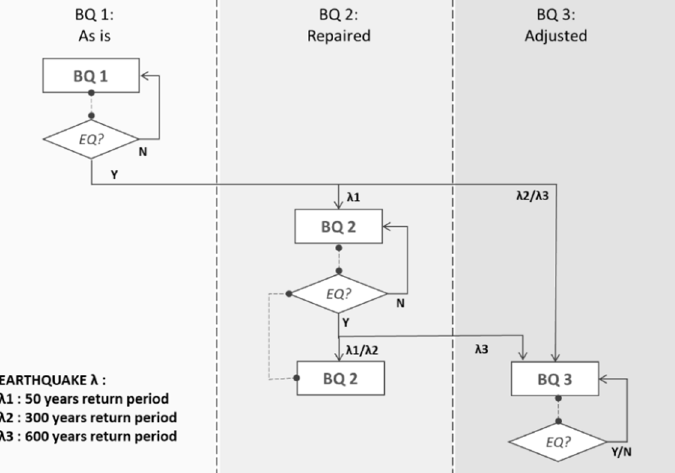
Figure 6. Building quality function variation depending on earthquake occurrence.